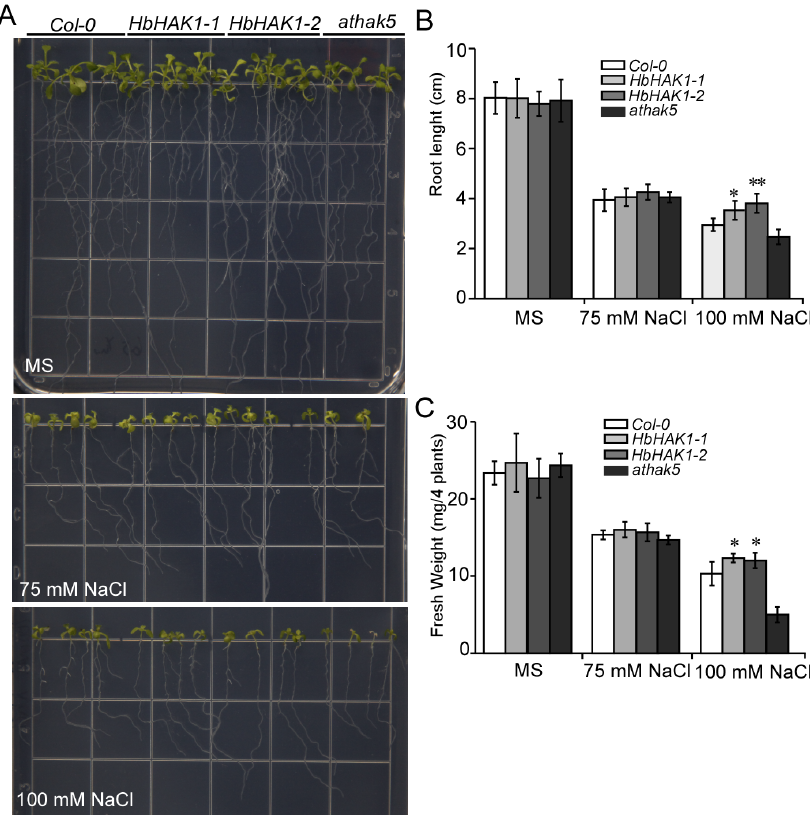
Figure 4. Expression of HbHAK1 improved the salt tolerance of plants. ( A ) Wild type, two HbHAK1-GFP transgenic lines in athak5 ( HbHAK1-1 and HbHAK1-2 ) and athak5 grown for 7 days on MS medium and then transferred MS with high NaCl concentration for another 7 days growth; ( B , C ) root length ( B ) and fresh weight ( C ) of plants in ( A ). Each bar represents the mean root length of 30 seedlings from three independent experiments in ( B ), and the mean fresh weight ( n = 3) of 4 seedlings in ( C ). Data represent mean ± SD; Student’s t -test was used to identify significant di ff erences at the p < 0.05 (*) and p < 0.01 level. (**)